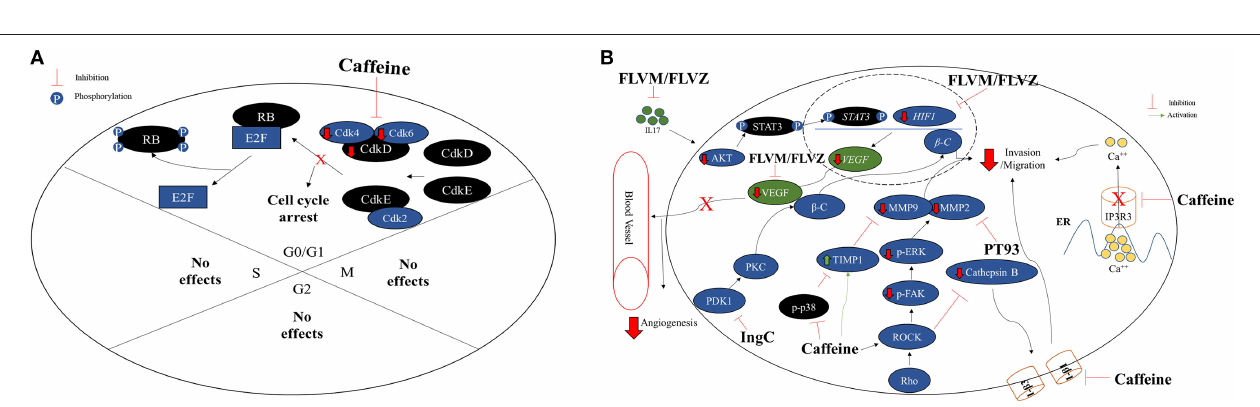
FIGURE 2 | (A) Caffeine arrests the cell cycle on G0/G1 phase in GBM cell lines. Normally, GO/G1 cell cycle phase is regulated by the CdkD and CdkE, which interacts with Cdk4, Cdk6 and Cdk2 forming CdkD/Cdk4,6 and CdkE/Cdk2 complexes. The CDK complexes are responsible for retinoblastoma (Rb) inactivation through phosphorylation and consequently, releasing the transcriptional factor E2F, retaining the cell cycle active. Caffeine appears to arrest the cell cycle in G0/G1 phase in GBM cell lines C6, U251, and U87MG by CDK complex inhibition. No caffeine effects were observed on S, G2, or M phases. (B) Effects of caffeine and compounds derived from caffeine on invasion/migration capacity and angiogenesis impairing in GBM cell lines. The caffeine can inhibit the IP3R3, an ER calcium receptor, which leads to a lower concentration of intracellular calcium, decreasing cell invasion and migration capacity. The rho-associated protein kinase (ROCK) cathepsin B/FAK/ERK pathway, associate with cellular invasion and migration, is also inhibited by caffeine through targeting phosphorylated p38 (p-p38) and ROCK proteins direct or by indirect inhibition through the TIMP-1 and integrins β 1 (I- β 1) and I- β 3, leading to lower MMP-2 and MMP-9. In addition, PT93, a compound derived from CA, acts direct in the inhibition of MMP-2 and contributing to lower cellular invasion or migration capacity. In the same way, the CA derivatives FLVM/FLVZ can either inhibit IL17 and HIF-1, leading to VEGF inhibition and angiogenesis impairing. The euphol derivative (IngC), on the other hand, acts in PKC and Wnt/ β -catenin ( β -C) pathways, inhibiting the PDK1, leading to lower concentration of β -C, an effector protein, consequently inhibiting the tumor invasion and migration.